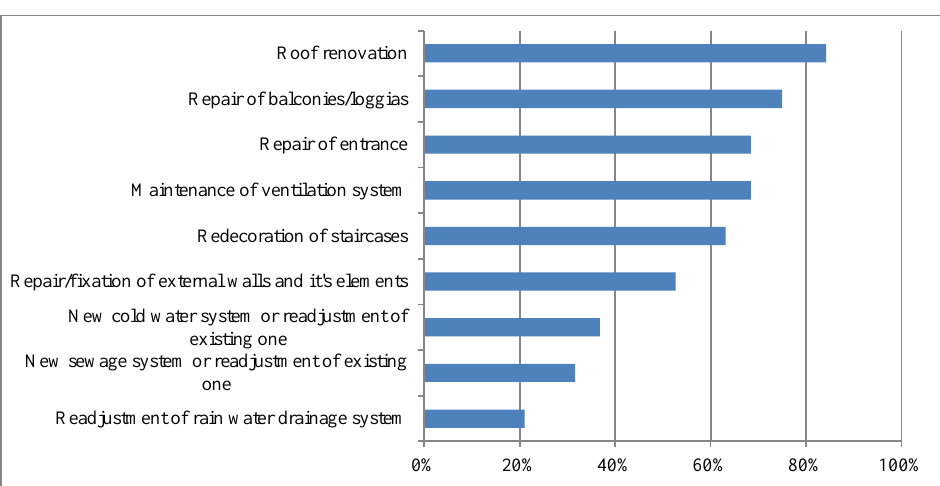
Fig. 2. Implemented structural